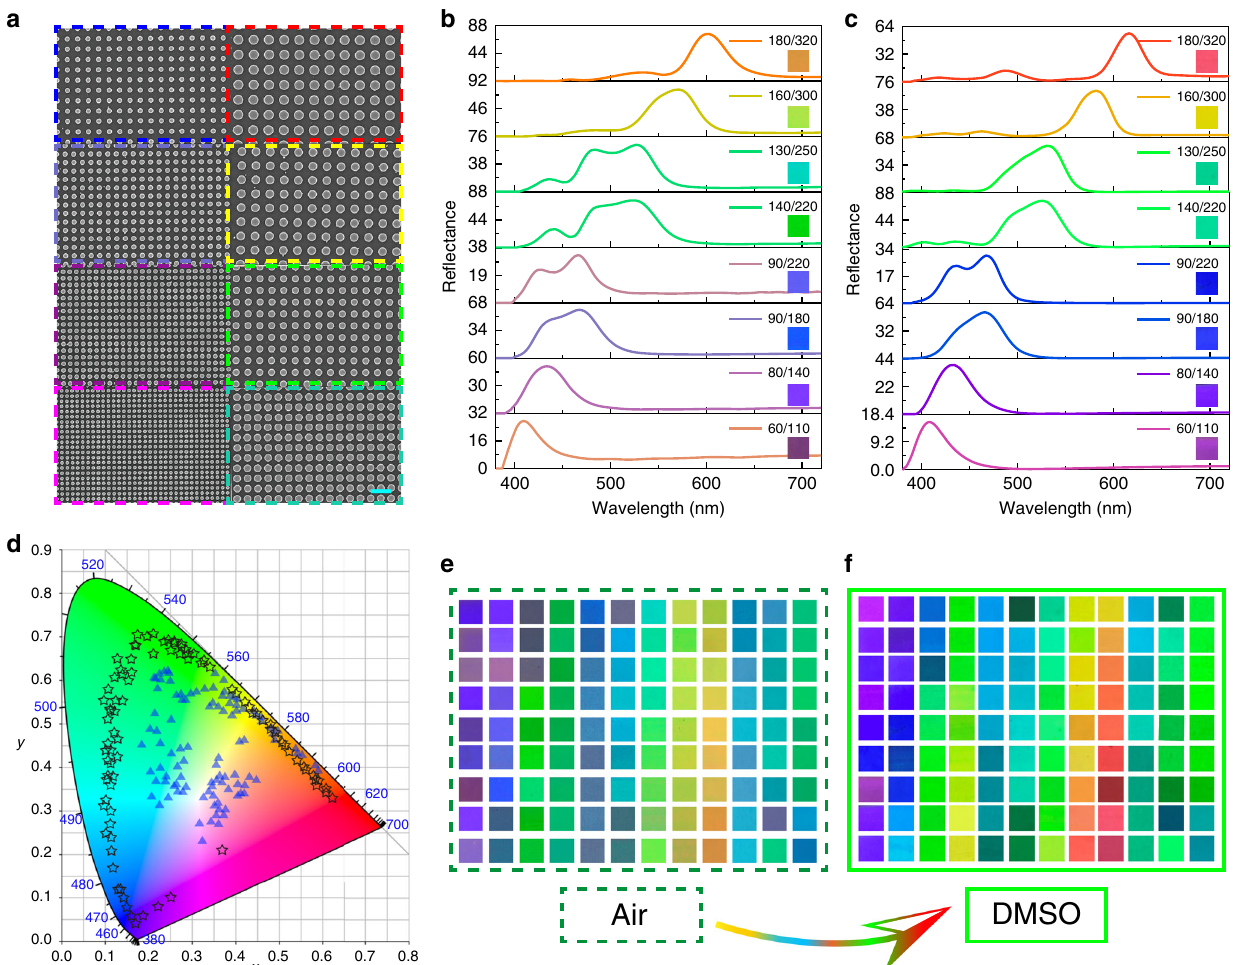
Fig. 3 The experimentally recorded structural color. a the top-view SEM images of the Si metasurfaces with different lattice sizes. The scale bar is 400 nm. Panels b , c are the experimentally recorded re fl ection spectra in air and in DMSO solution. The insets are their displayed colors under bright- fi eld microscope. d The experimentally recorded color palettes of 108 Si metasurfaces in air (triangles) and in DMSO (stars), respectively. Panels e , f are the experimentally recorded color palettes of 108 Si metasurfaces in air and in DMSO,